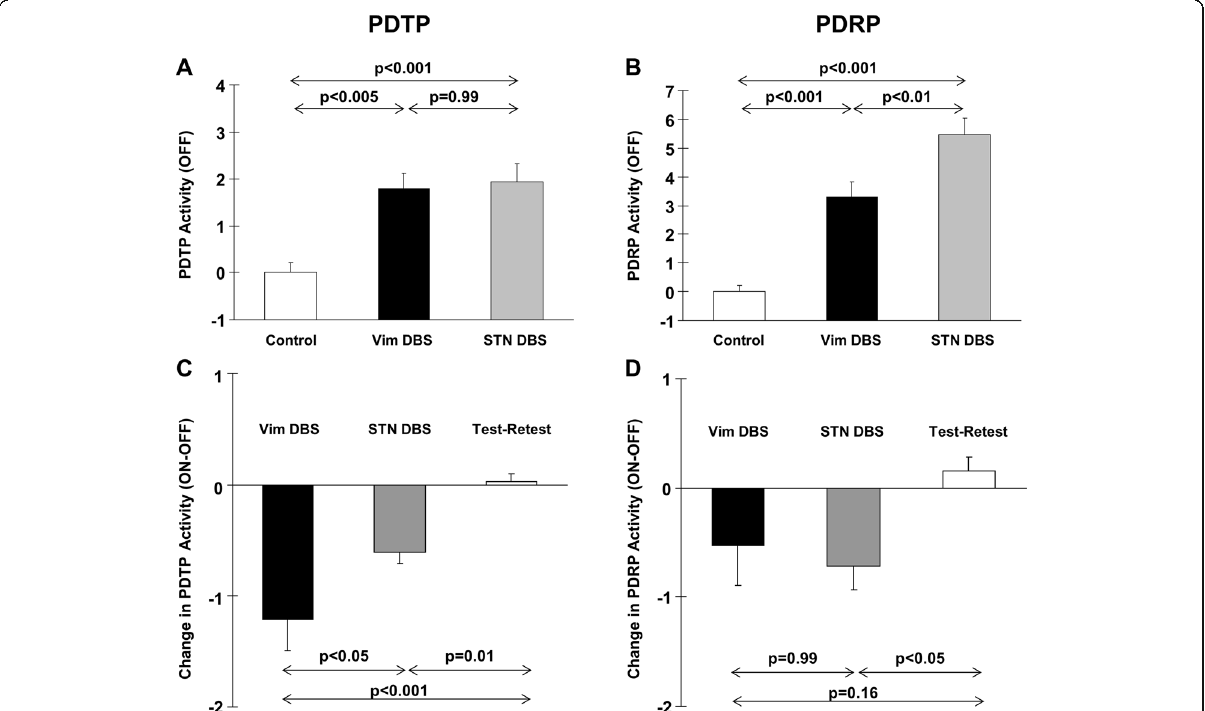
Fig. 3 Mean baseline and changes in metabolic network activity of PDTP/PDRP with deep brain stimulation in PD. a/b . Baseline activity of both networks was elevated in the Vim STN and the STN DBS groups relative to normal controls. PDTP activity was comparable between the two DBS treatment groups although PDRP activity was higher in the STN than in the Vim DBS group ( p < 0.01). c/d . STN DBS reduced activity of both networks compared to the test-retest PD group ( p < 0.05) while Vim DBS changed PDTP activity ( p < 0.001) but did not alter PDRP activity. PDTP activity was suppressed more by Vim DBS than by STN DBS ( p < 0.05). [Data are presented as mean and standard error; Reprinted from Neuroimage 54:1244 – 1253. Mure H, Hirano S, Tang CC, Isaias IU, Antonini A, Ma Y, Dhawan V, Eidelberg D. Parkinson ’ s disease